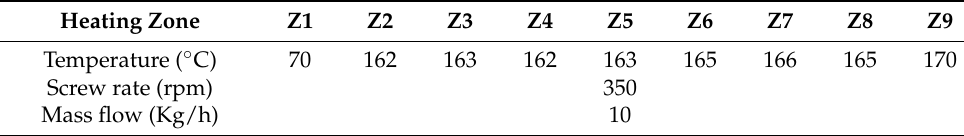
Table 2. Extrusion conditions for the compound